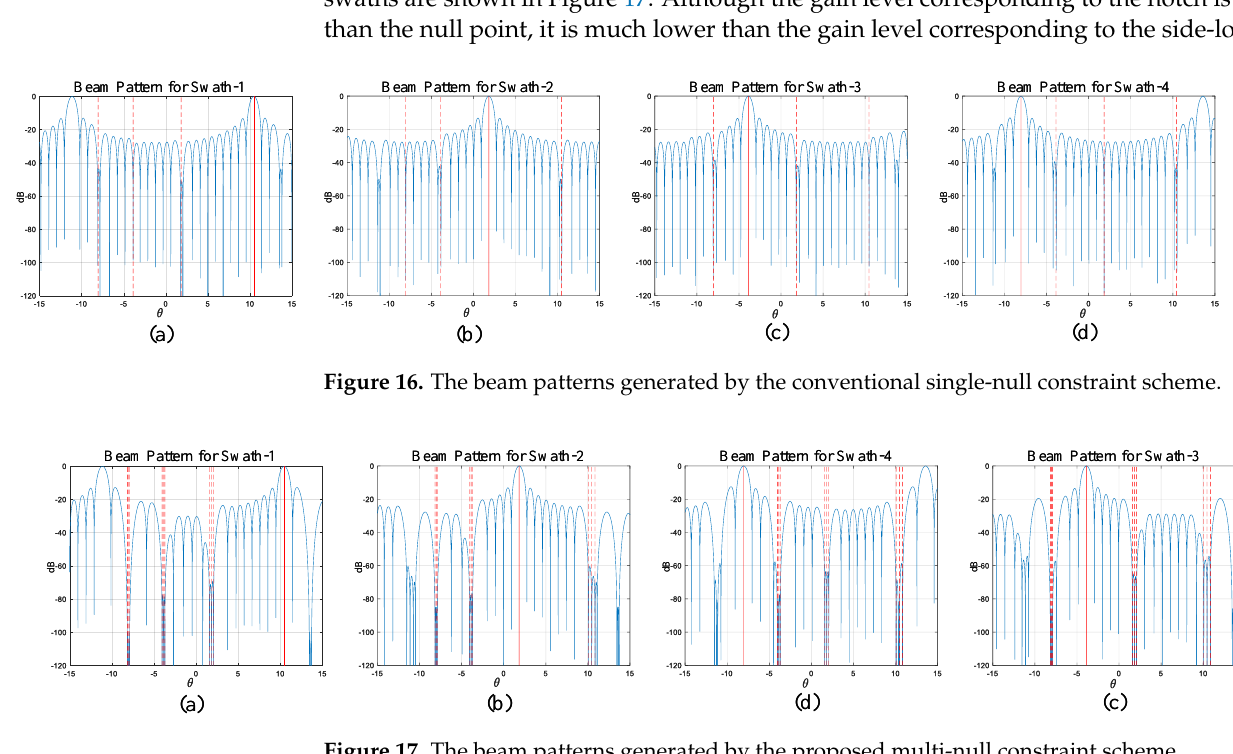
Figure 17. The beam patterns generated by the proposed multi-null constraint